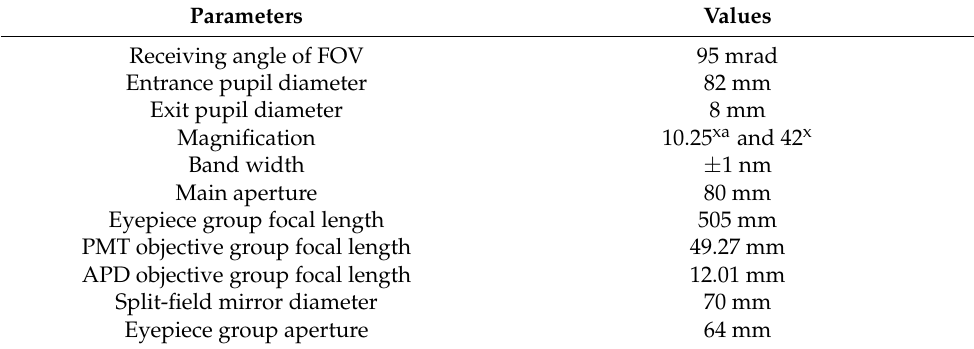
Figure 6. Architecture of the receiving optical system. Table 5. The specification of the receiving optical system in GQ-Cor 19.